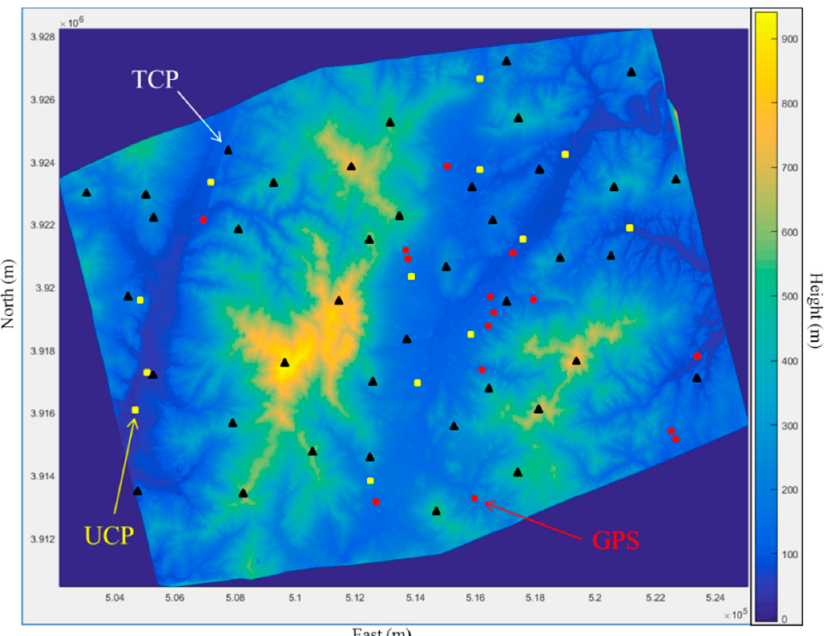
Figure 6. Generated DEM for the Yangsan region. UCPs, TCPs and GPS check points are